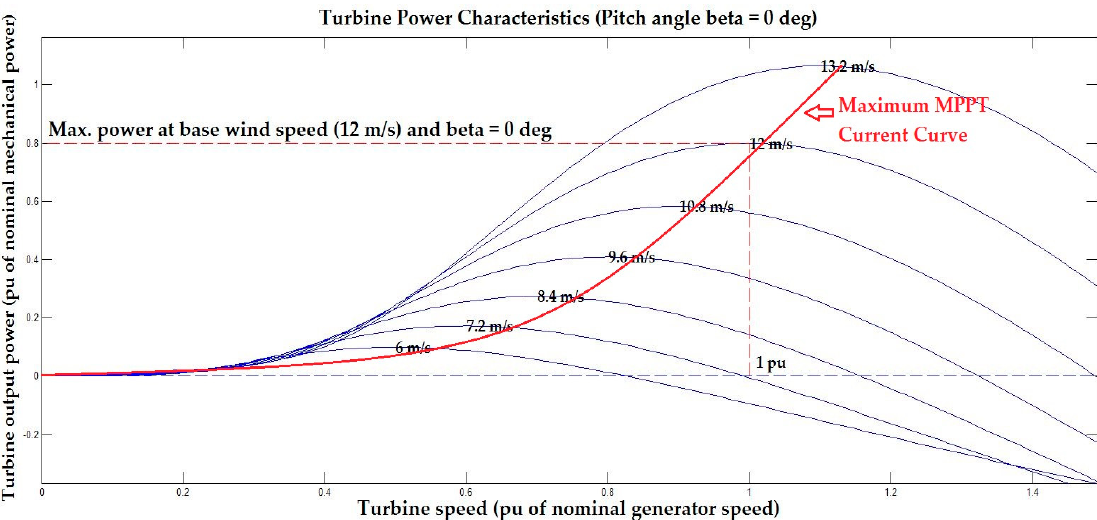
Figure 4 . Wind turbine reference current curve. Figure 4. Wind turbine reference current